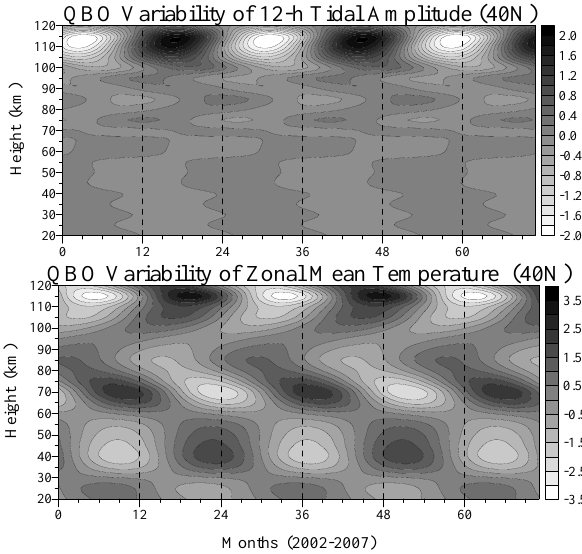
Figure 11 Fig. 11. Semidiurnal tidal amplitude (upper plot) and zonal mean temperature (bottom plot) variations for QBO period of 28 months plotted versus height and months for period of time between Jan- uary 2002 and December